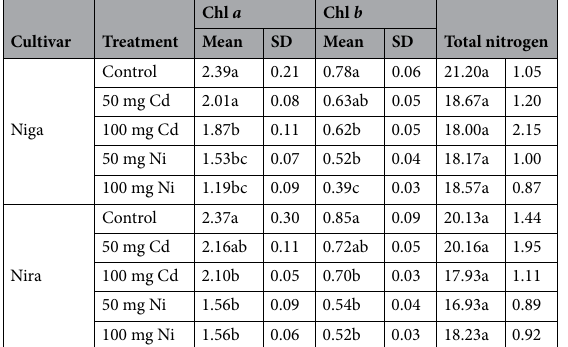
Table 2. Chlorophyll and total nitrogen concentration in leaves [mg × g −1 F.W.] ± S.D of two perennial ryegrass turf cultivars (‘Niga’ and ‘Nira’) under different Ni and Cd treatment (0; 50 and 100 mg × 100 g −1 of substrate). Means within one cultivar marked by different letters represent statistically significant differences ( p < 0.05, n = 6).